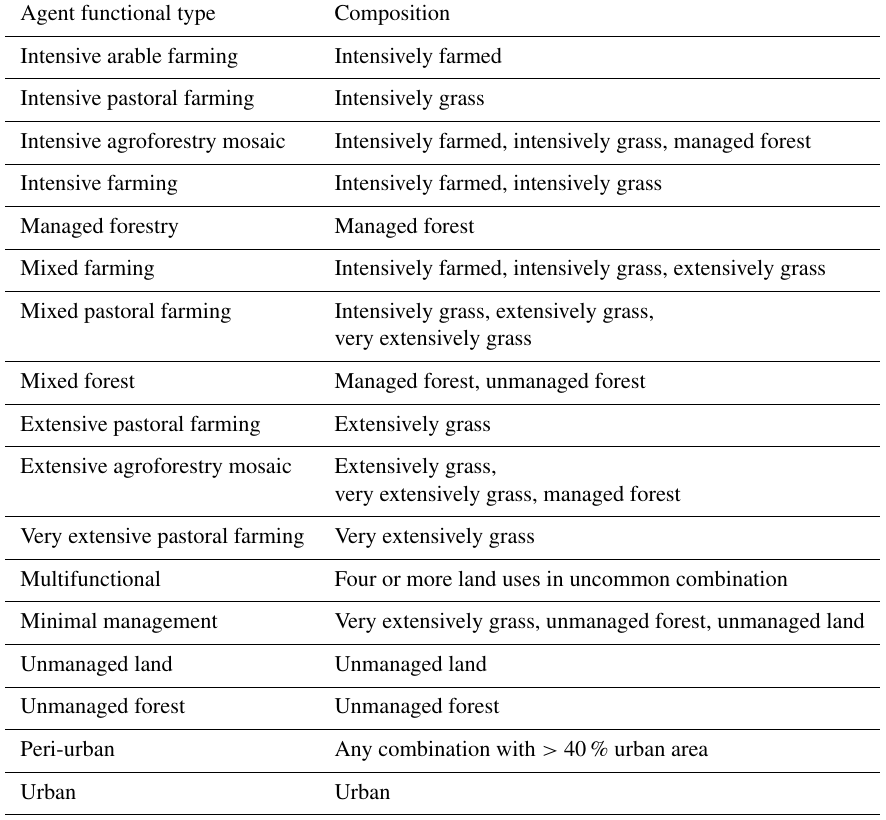
Table A1. The composition of agent functional types (AFTs) in CRAFTY-EU in terms of baseline IAP land use categories. In any case in which the given IAP categories occupy more than 70% of a cell, that cell is allocated to the corresponding AFT in the baseline map of CRAFTY-EU, except in the case of the peri-urban AFT, for which the threshold (of urban area) is